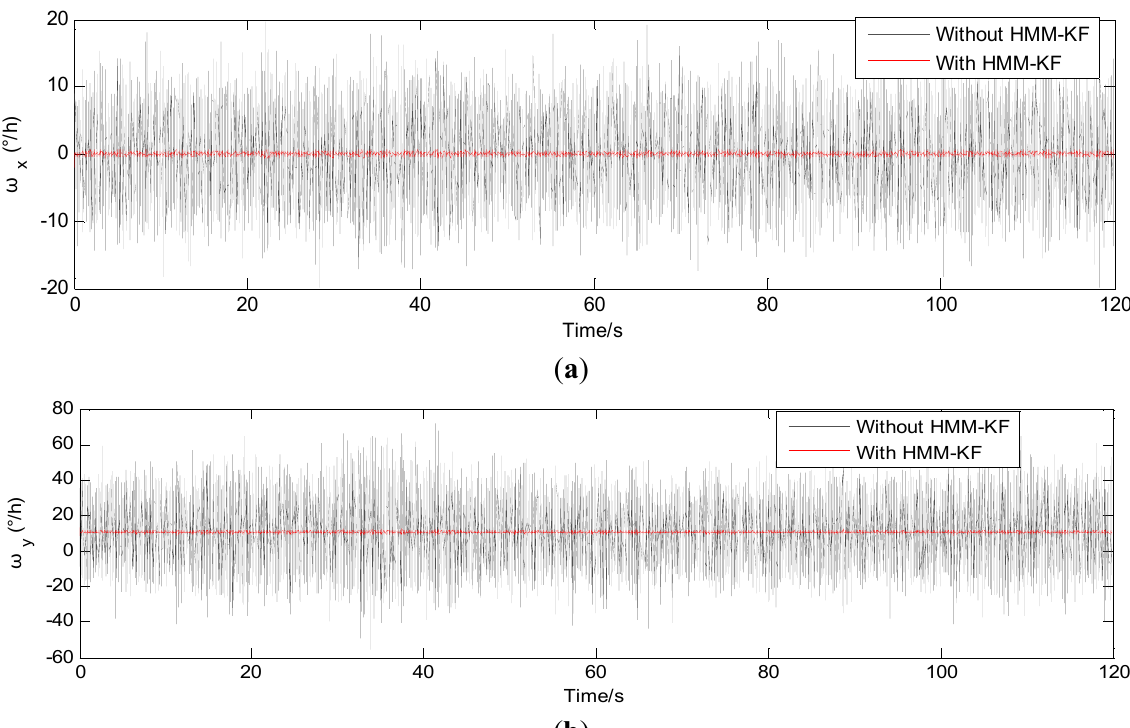
Figure 5. Time-domain analysis of the gyroscope outputs with and without